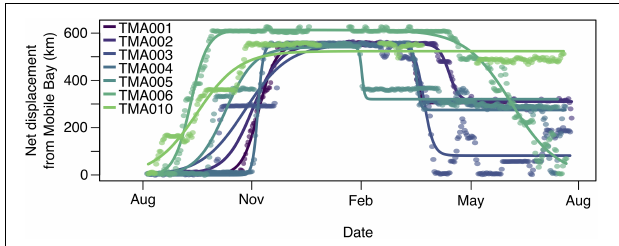
FIGURE 4 | Best fitting net-squared displacement models of migratory movement for seven tagged manatees for which satellite telemetry data were available for both autumn and spring migrations. Displacement was measured as distance from Mobile Bay, Alabama.